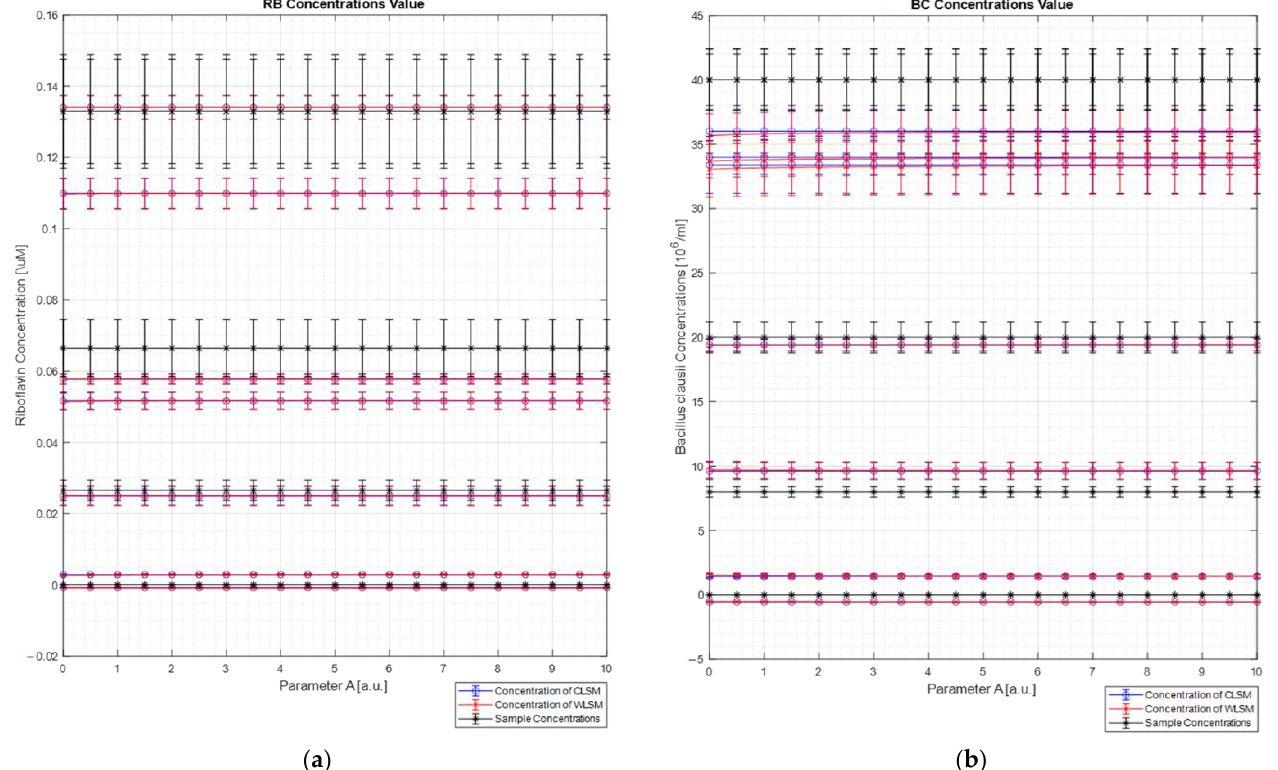
Figure 9. Concentration measurement results for each biological agent (Riboflavin ( a ) and Bacillus clausii ( b )) for each sample. In particular, in each plot, the expected concentrations of each biological agent in each sample (black star) are plotted with its bar of uncertainty value related to the dilution and mixture preparation. The concentrations of each agent calculated by C-LSM are reported in blue, while the concentrations of each agent calculated by W DIF -LSM are shown in red. Each calculated concentration value is indicated with its error bar, which is the uncertainty of the value calculated as the product between the reconstruction error and the concentration calculated by the algorithms.